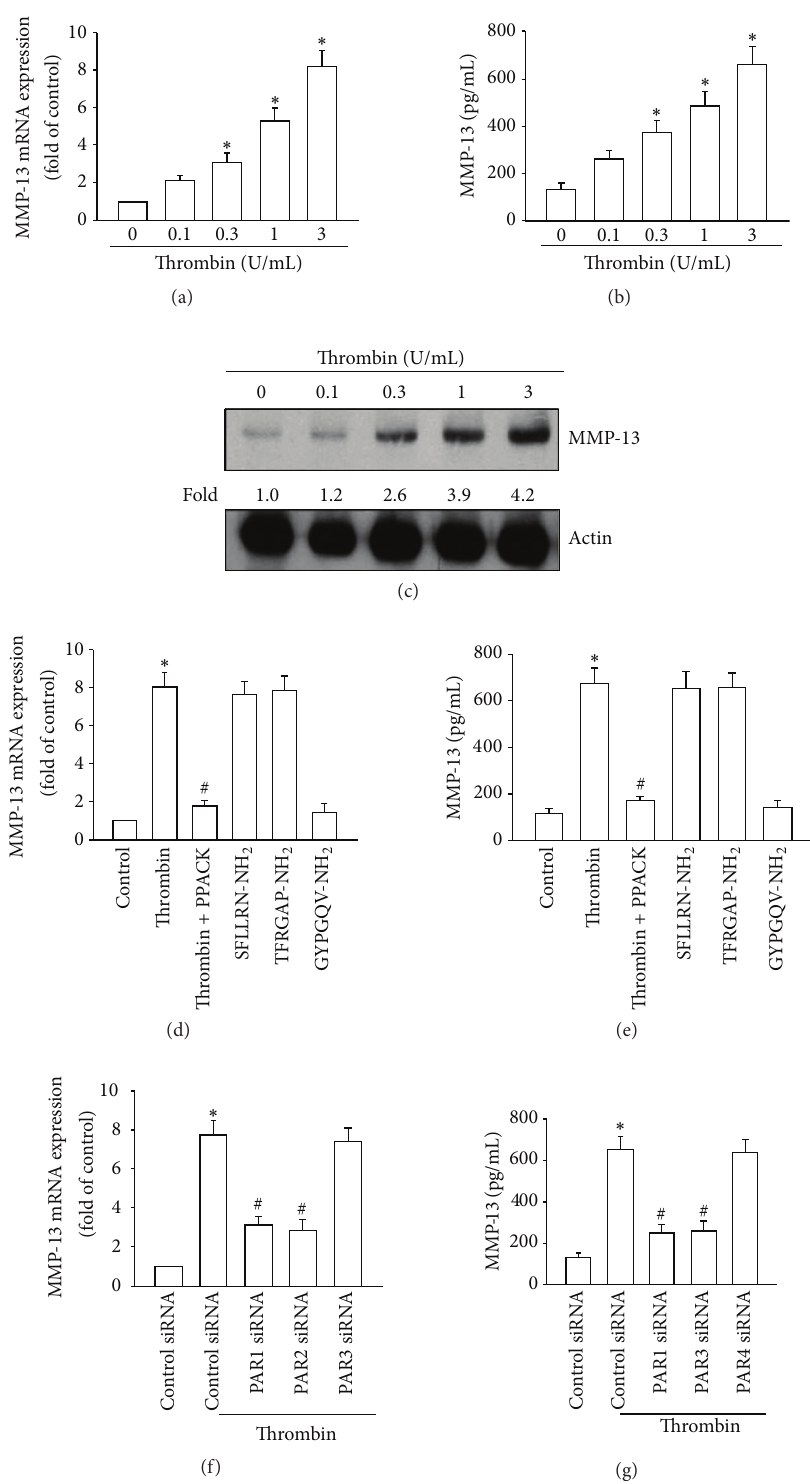
Figure 1: Involvement of PAR1/PAR3 receptor in thrombin-induced MMP-13 expression in human chondrocytes (a) qPCR analyses of MMP- 13 mRNA and (b) and (c) ELISA and Western blotting analyses of protein expression of MMP-13 in chondrocytes incubated with thrombin for 24h. (d) and (e) qPCR and ELISA analyses of MMP-13 expression in chondrocytes treated with thrombin alone (3U/mL), thrombin + PPACK (30nM), SFLLRN-NH 2 (100 𝜇 M), thrombin + TFRGAP-NH 2 (100 𝜇 M), or thrombin + GYPGQV-NH 2 (100 𝜇 M) for 24 h. (f) and (g) qPCR and ELISA analyses of MMP-13 expression in chondrocytes, which were transfected with siRNAs against PAR1, PAR3, PAR4, or control siRNA for 24h and then stimulated with thrombin for 24 h. ∗ 𝑃 < 0.05 as compared with basal level. # 𝑃 < 0.05 as compared to the levels in the thrombin-treated